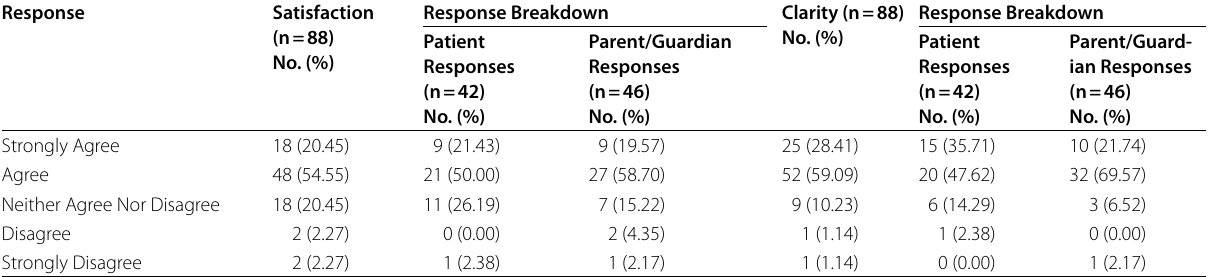
Table 2 *Response Ratings of Questionnaire Satisfaction and Clarity (Aggregate Data Across Versions)